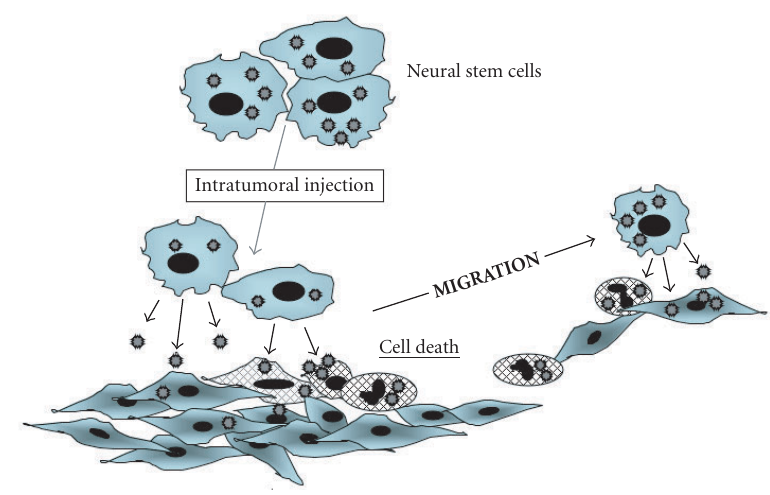
Figure 1. Prospective gene therapy for malignant gliomas.